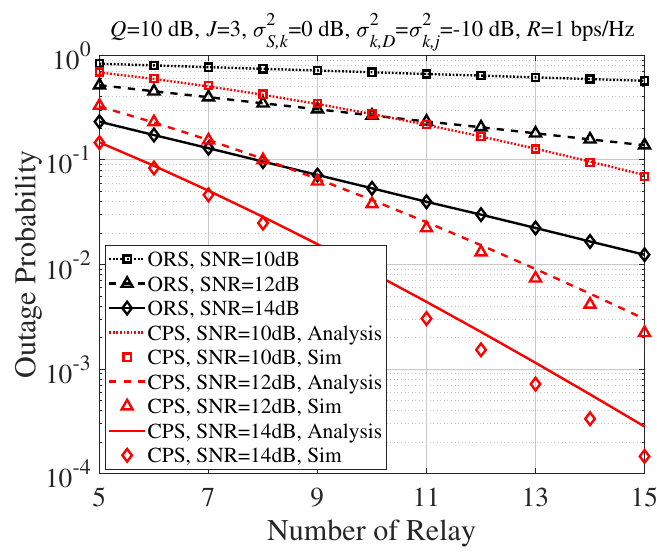
Figure 3. Outage probability according to K .